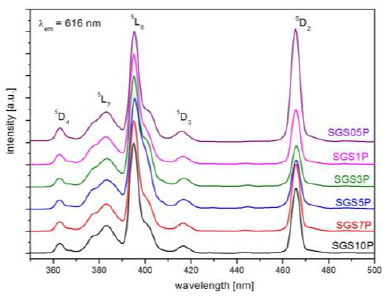
Figure 1. The excitation spectra of SGS05P, SGS1P, SGS3P, SGS5P, SGS7P, and SGS10P glass samples monitored at 616